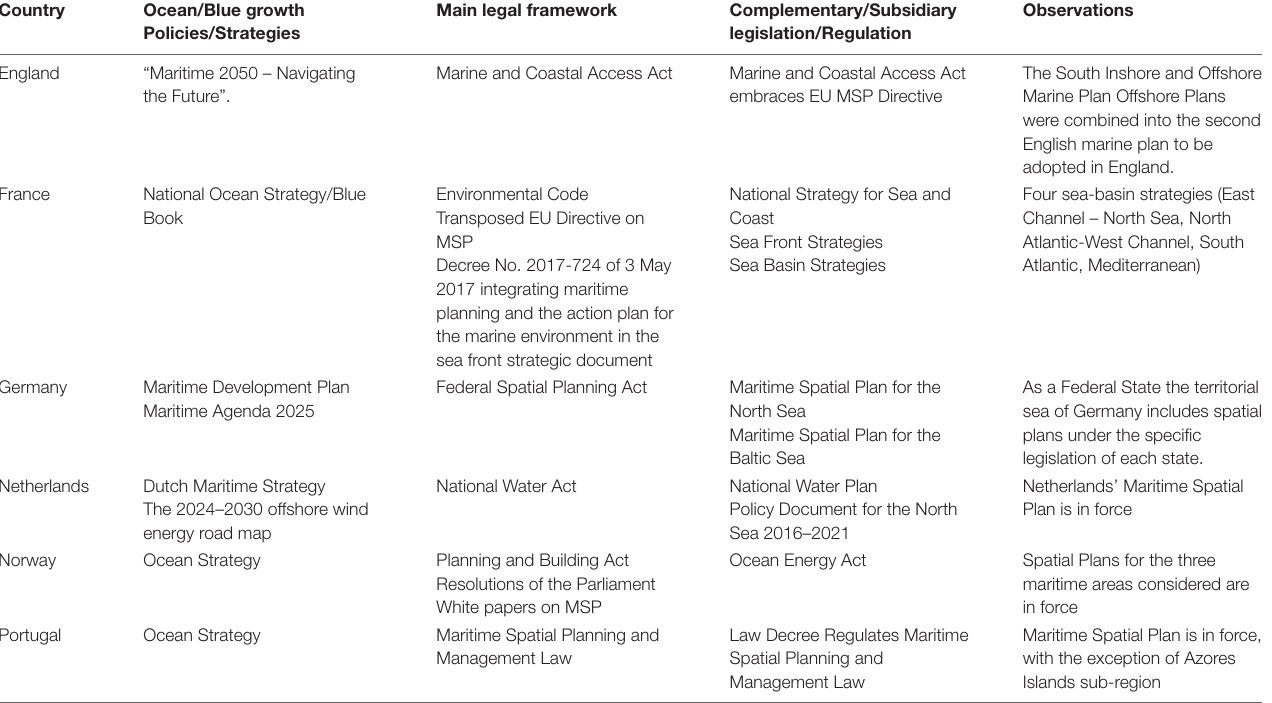
TABLE 2 | Legal framework for blue growth and maritime space governance in European case